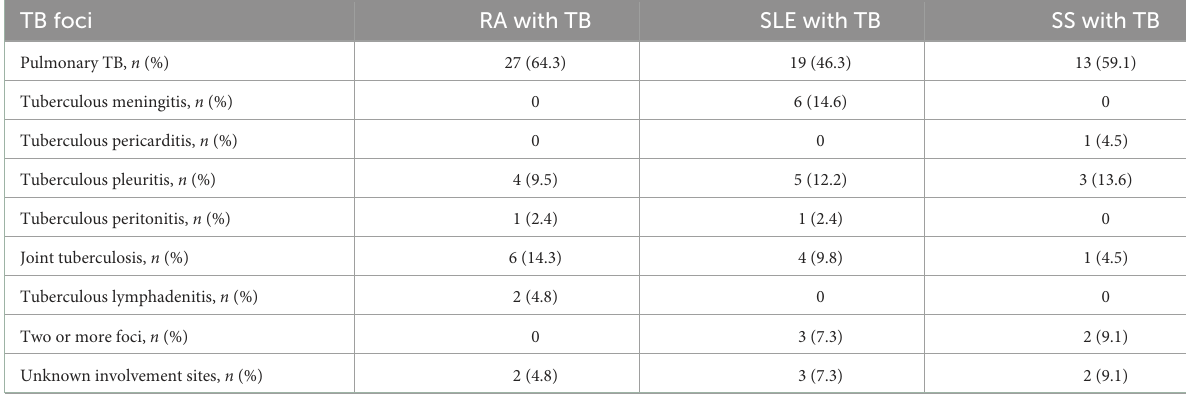
TABLE 3 Distribution of TB foci in the TB group.